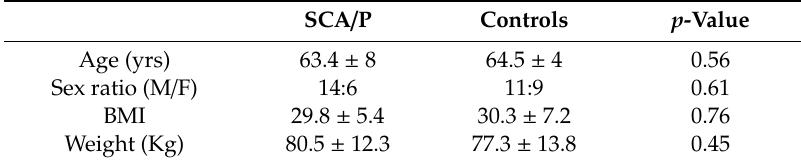
Table 1. Main demographical and anthropometric features of the subjects enrolled in the